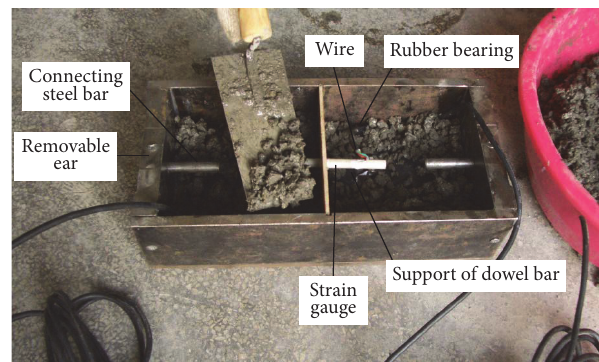
Figure 5: Placing concrete into the formwork.